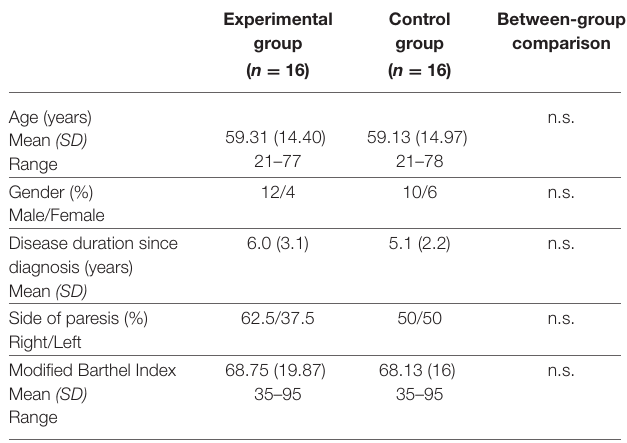
TABLE 1 | Demographic and clinical characteristics of treated subjects.